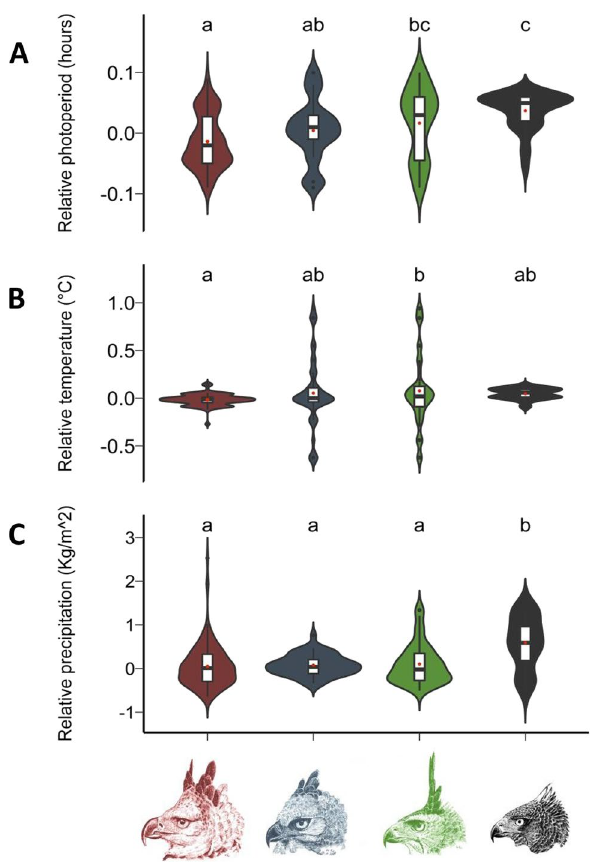
Figure 3. Violin plots of the relative changes in ( A ) photoperiod, ( B ) temperature and ( C ) precipitation in which clutch initiation occurred in the four Neotropical species surveyed in this study. Red, blue, green and black violin plots represent values obtained from Harpy eagles, Crested eagles, Ornate hawk-eagles and Black hawk-eagles, respectively. Black horizontal lines indicate medians whereas red dots depict means. Boxes illustrate interquartile range and outliers 1.5 times the interquartile range from the box are shown as dots. Different letters indicate statistical differences between species within the same environmental factors ( P <